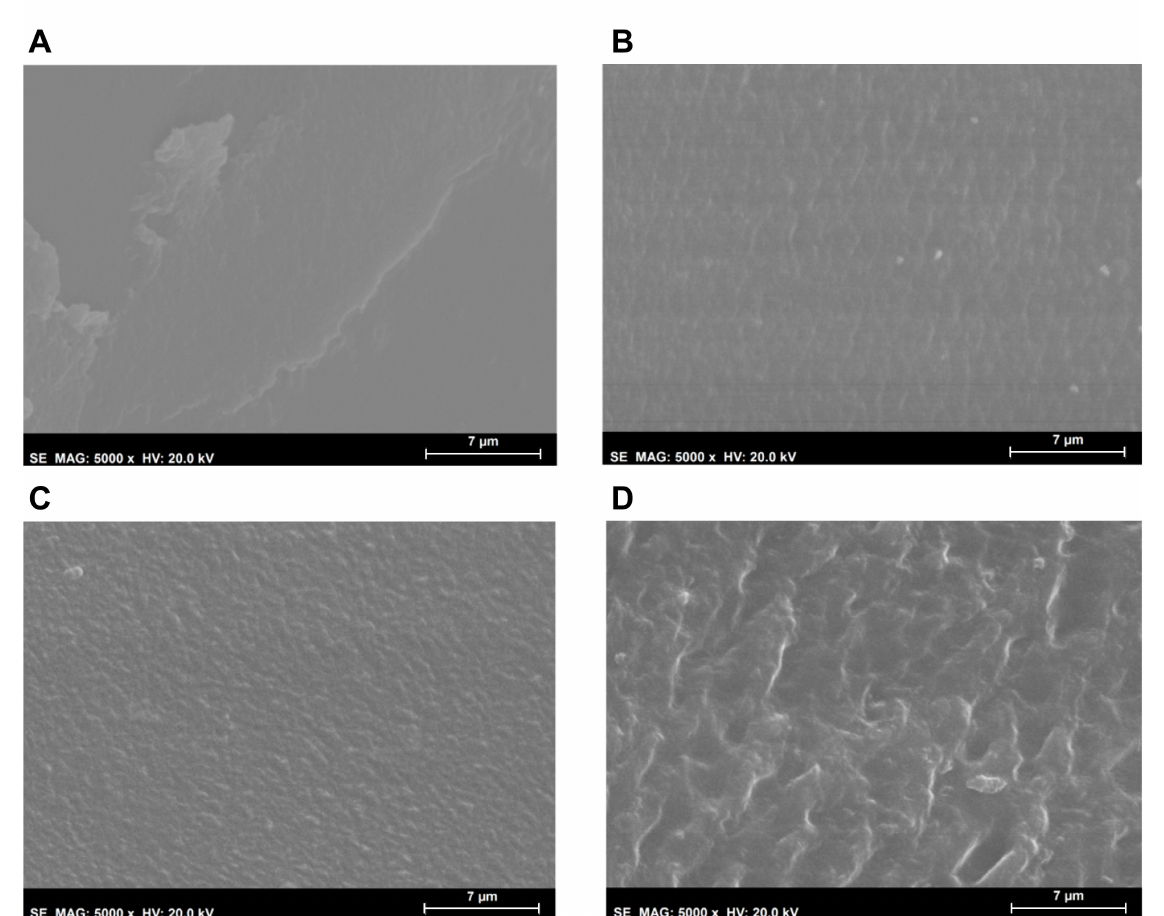
Figure 10. SEM micrographs (5000 × magnification, scale bar 7 µ m) of the PVA/PBO hydrogels inside the wear tracks, produced in the tribological experiments. Non-sterile ( A ), MW-3 ( B ), HHP ( C ), and PM ( D )